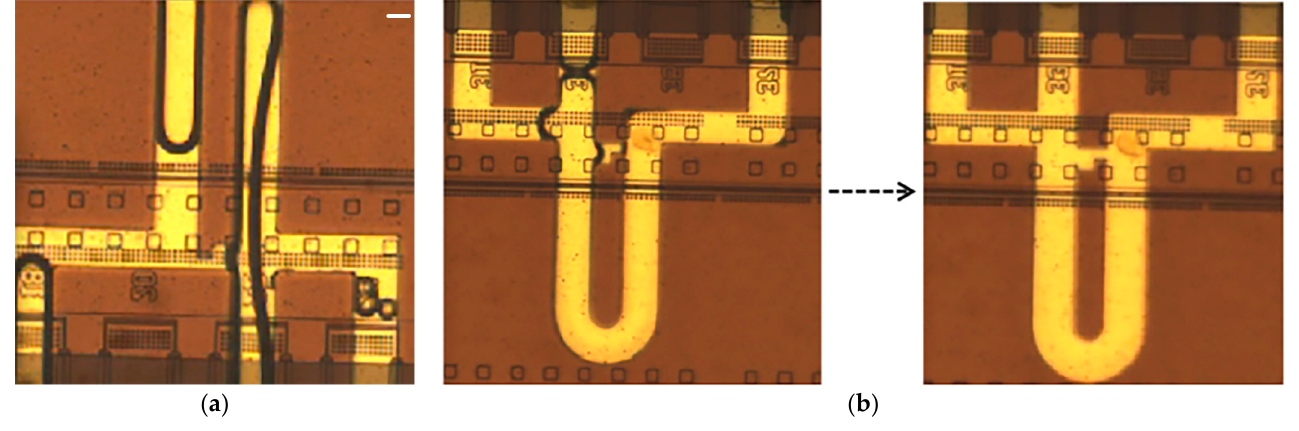
Figure 4. A comparison of the flow channel without pretreatment and the flow channel with pretreatment. ( a ) The flow channel without pretreatment produced large bubbles after the cell suspension was added, which affected the conduct of the experiment. ( b ) A diagram of microchannel preprocessing: after adding 75% ethanol solution to the runner, the runner is quickly soaked in 75% ethanol solution, and no bubbles are produced.